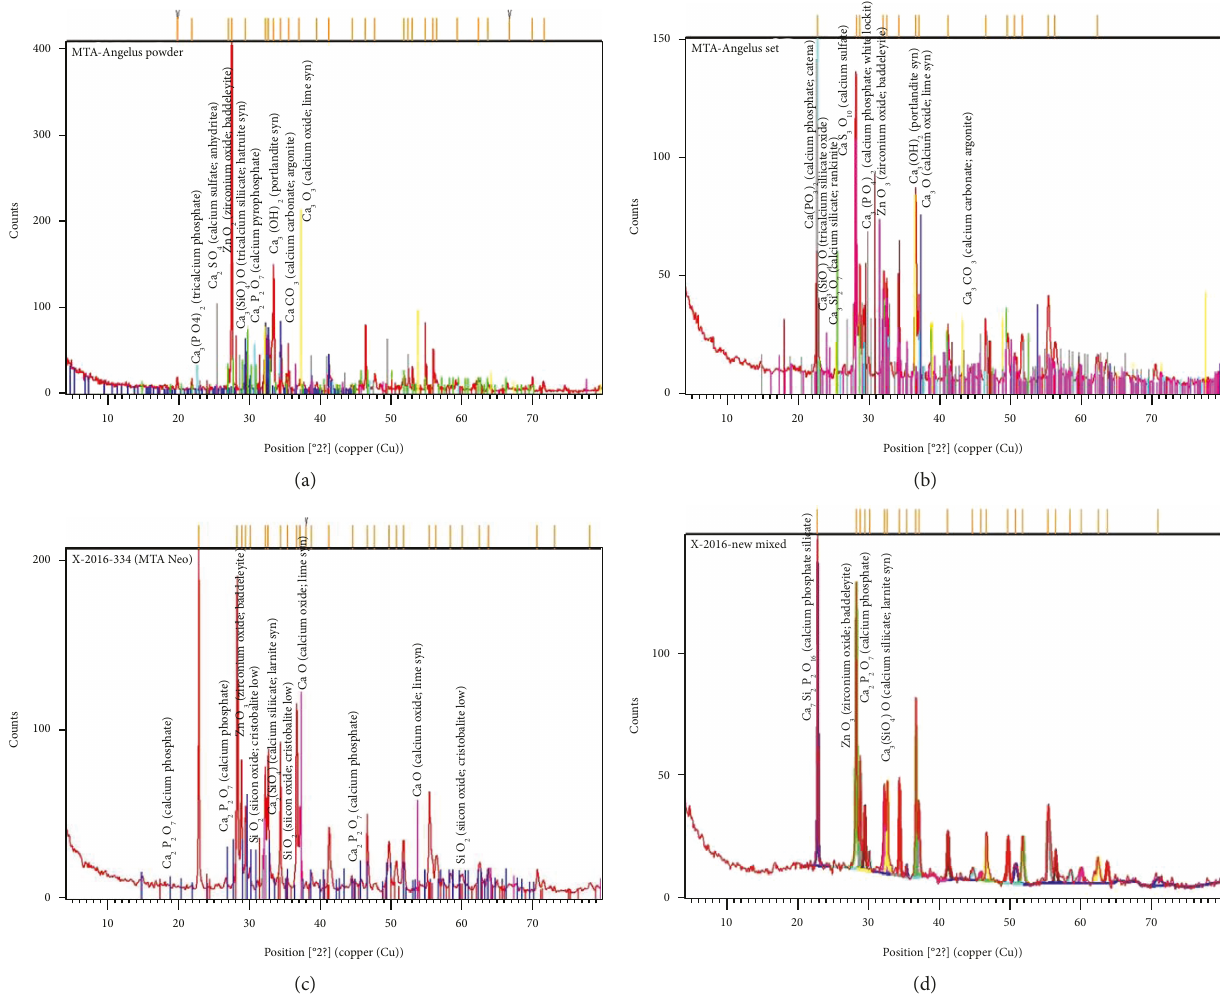
Figure 2: XRD of MTA Angelus powder (a), MTA Angelus hydrated (b), NeoMTA Plus powder (c), and NeoMTA Plus hydrated